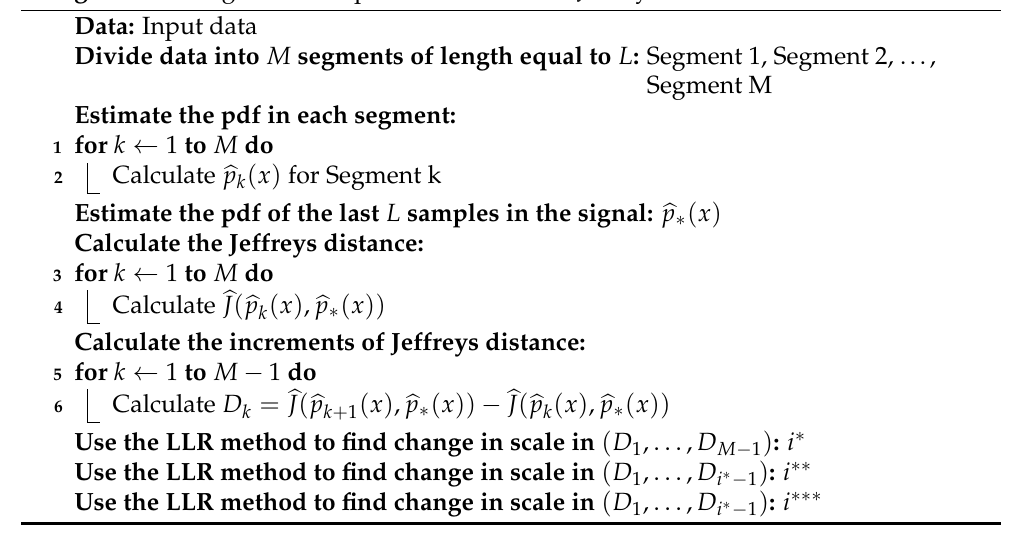
Algorithm 1: Segmentation procedure based on Jeffreys